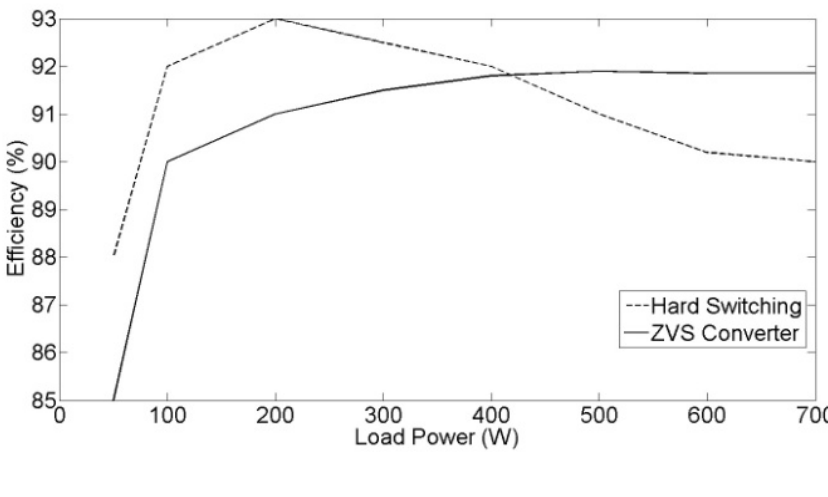
Figure 12. Efficiency vs. load